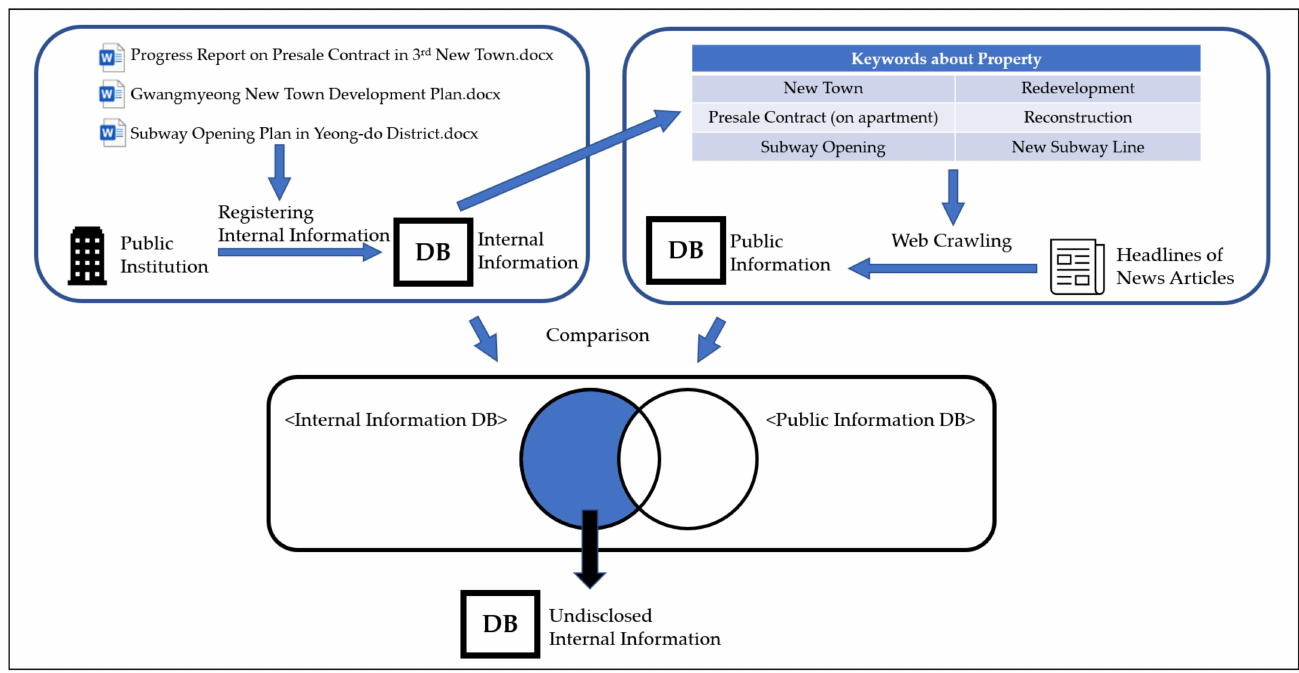
Figure 3. Process of Generating an undisclosed internal information